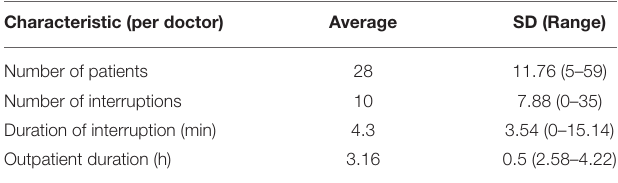
TABLE 3 | Characteristics of doctors in outpatient department.